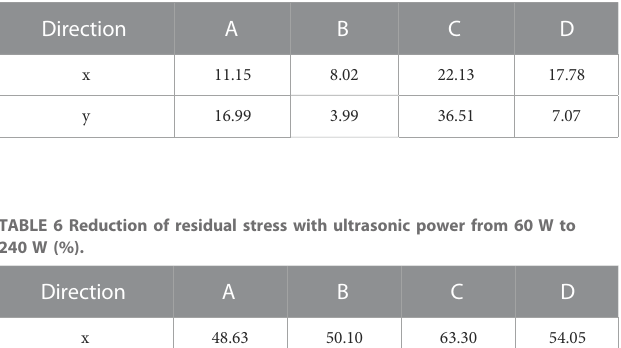
TABLE 5 Reduction of residual stress with ultrasonic power from 0W to 60 W (%).